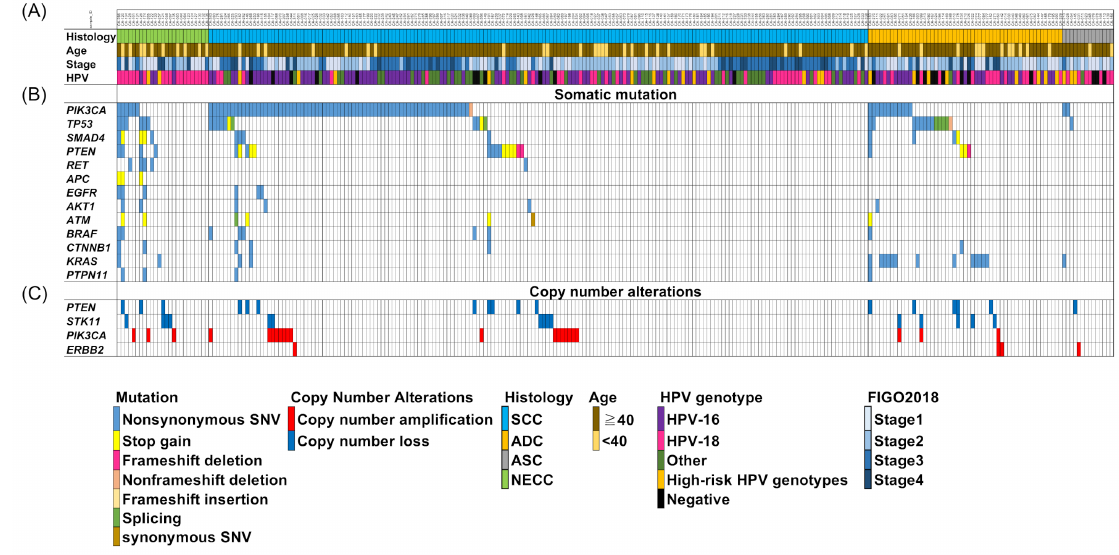
Figure 1. Somatic alterations in cervical cancer and associated clinicopathological features. Two hundred and seventy- two cases were categorized according to their ( A ) histological types and clinicopathological features, ( B ) major mutated genes of neuroendocrine carcinoma, and ( C ) copy number alterations. Mutated genes are color-coded according to their mutation